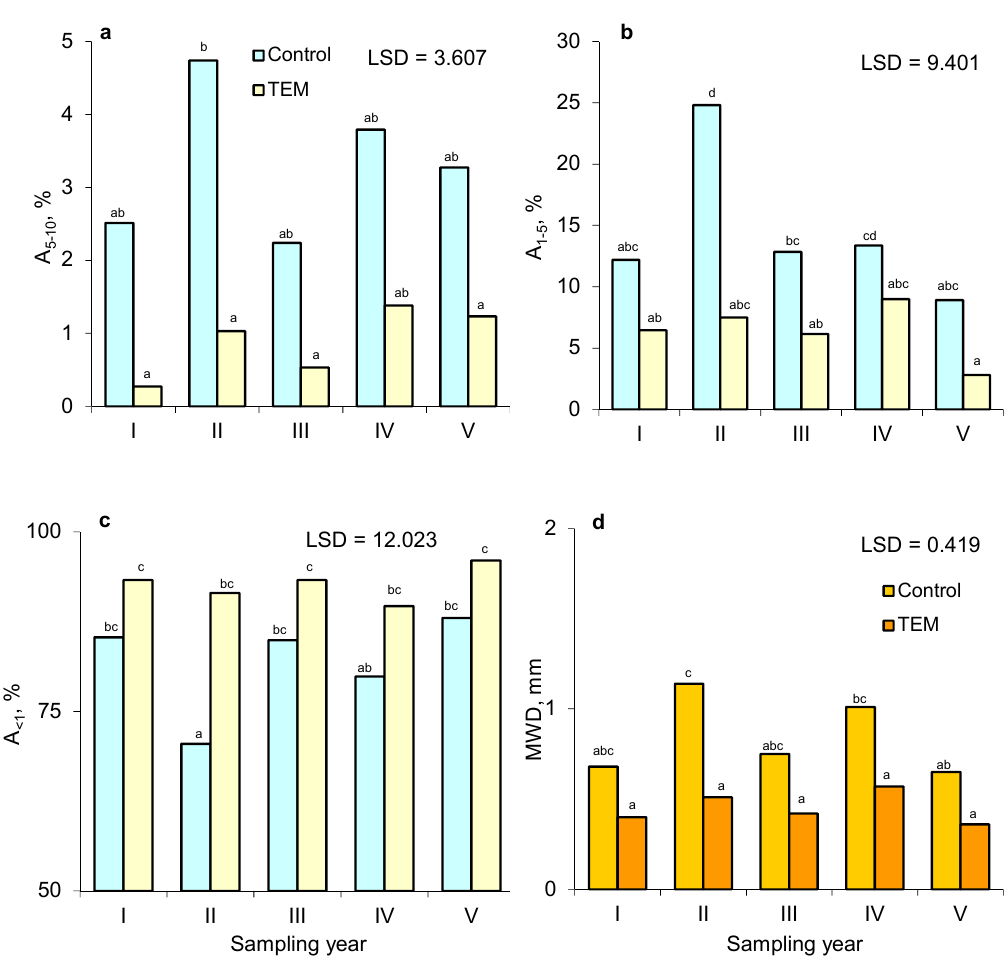
Figure 8. The annual mean values of water-stable aggregate content: A 5–10 ( a ), A 1–5 ( b ), A < 1 ( c ), and mean weight diameter (MWD) ( d ) during the five-year study. Notes: Control: soil without EM-A ( n = 150), TEM: soil with EM-A application ( n = 150), I–V: study year. Each letter (a, ab, abc, b, bc, c, cd and d) means a significant di ff erence (Control or TEM × study year) according to Tukey’s lowest significant di ff erence